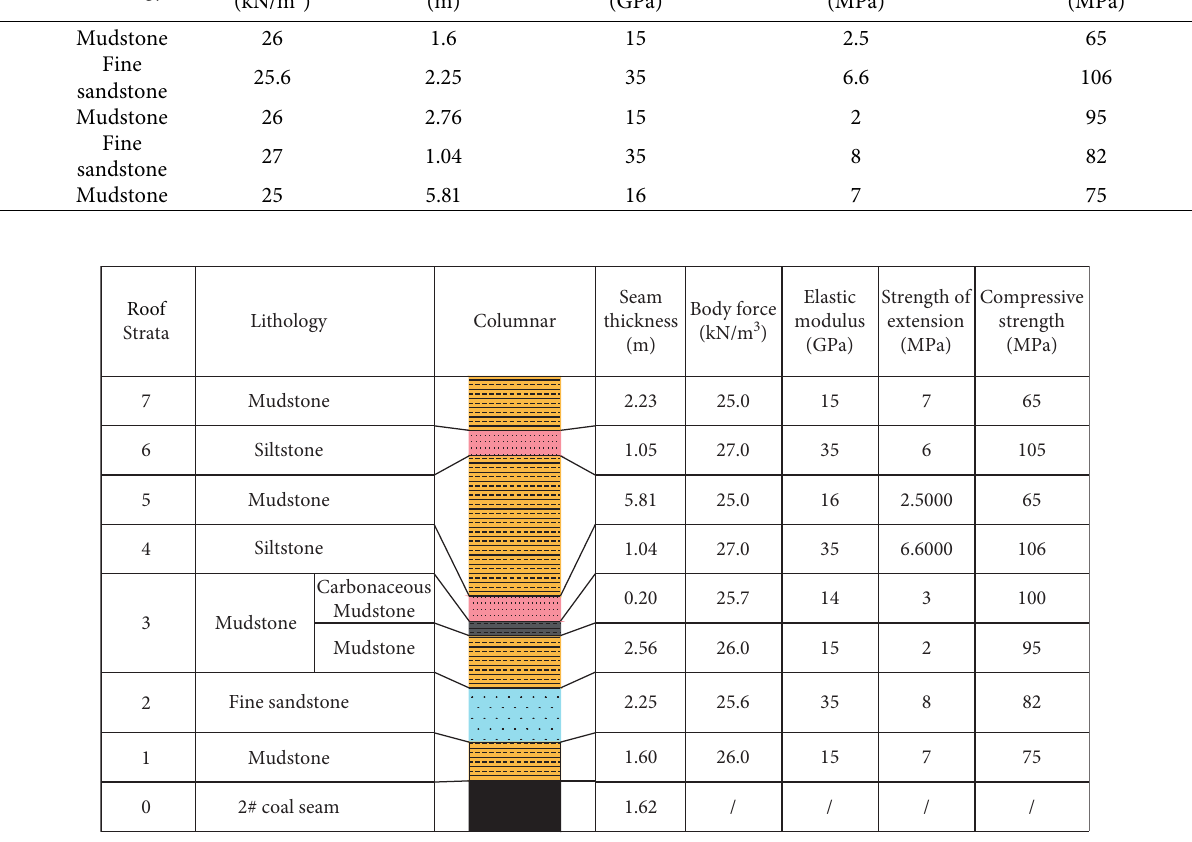
Figure 8: The geological comprehensive histogram of 2# coal seam. Table 3: Calculation of the values of each parameter of x